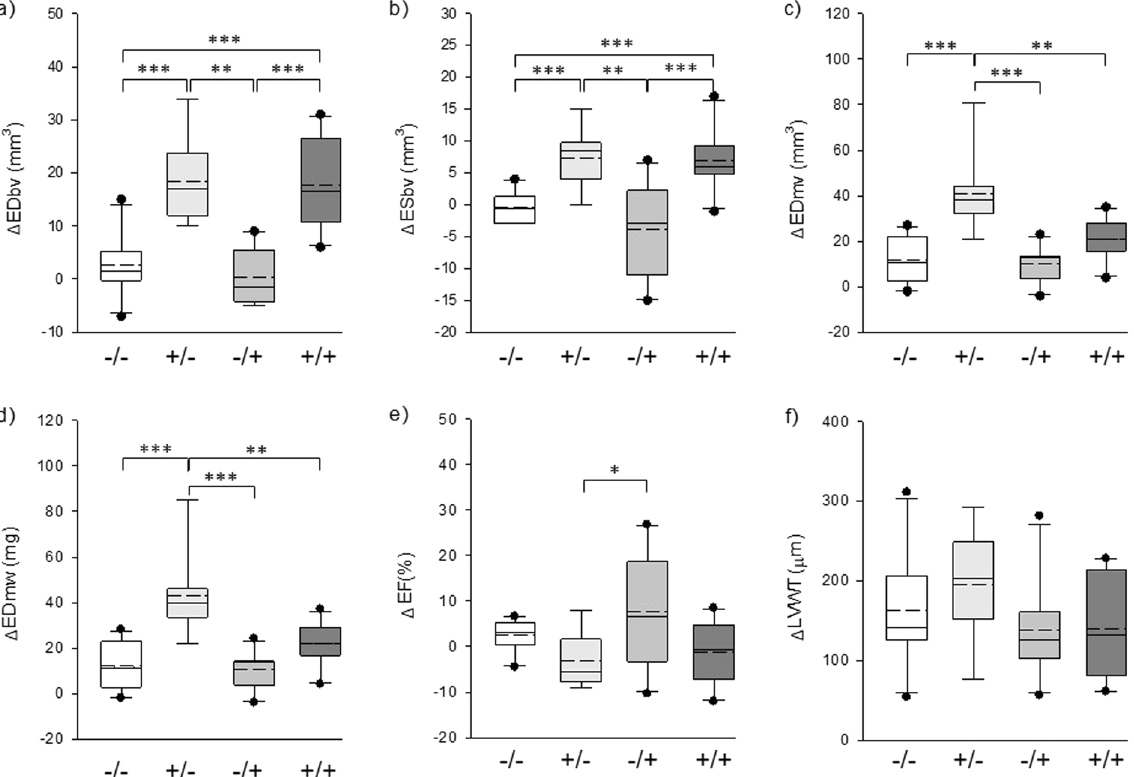
Figure 4. Graphs displaying the differential value of cardiac function and anatomy-indicating factors between before and after administration of AngII or sRAGE. ( a ) EDbv, ( b ) ESbv, ( c ) EDmv, ( d ) EDmw, ( e ) EF of LV, ( f ) LVWT. − / − : saline group, + / − : AngII group, − / + : sRAGE group, + / + , AngII + sRAGE group. Straight line: median value, dashed line: mean value, * p < 0.05, ** p < 0.01, *** p <